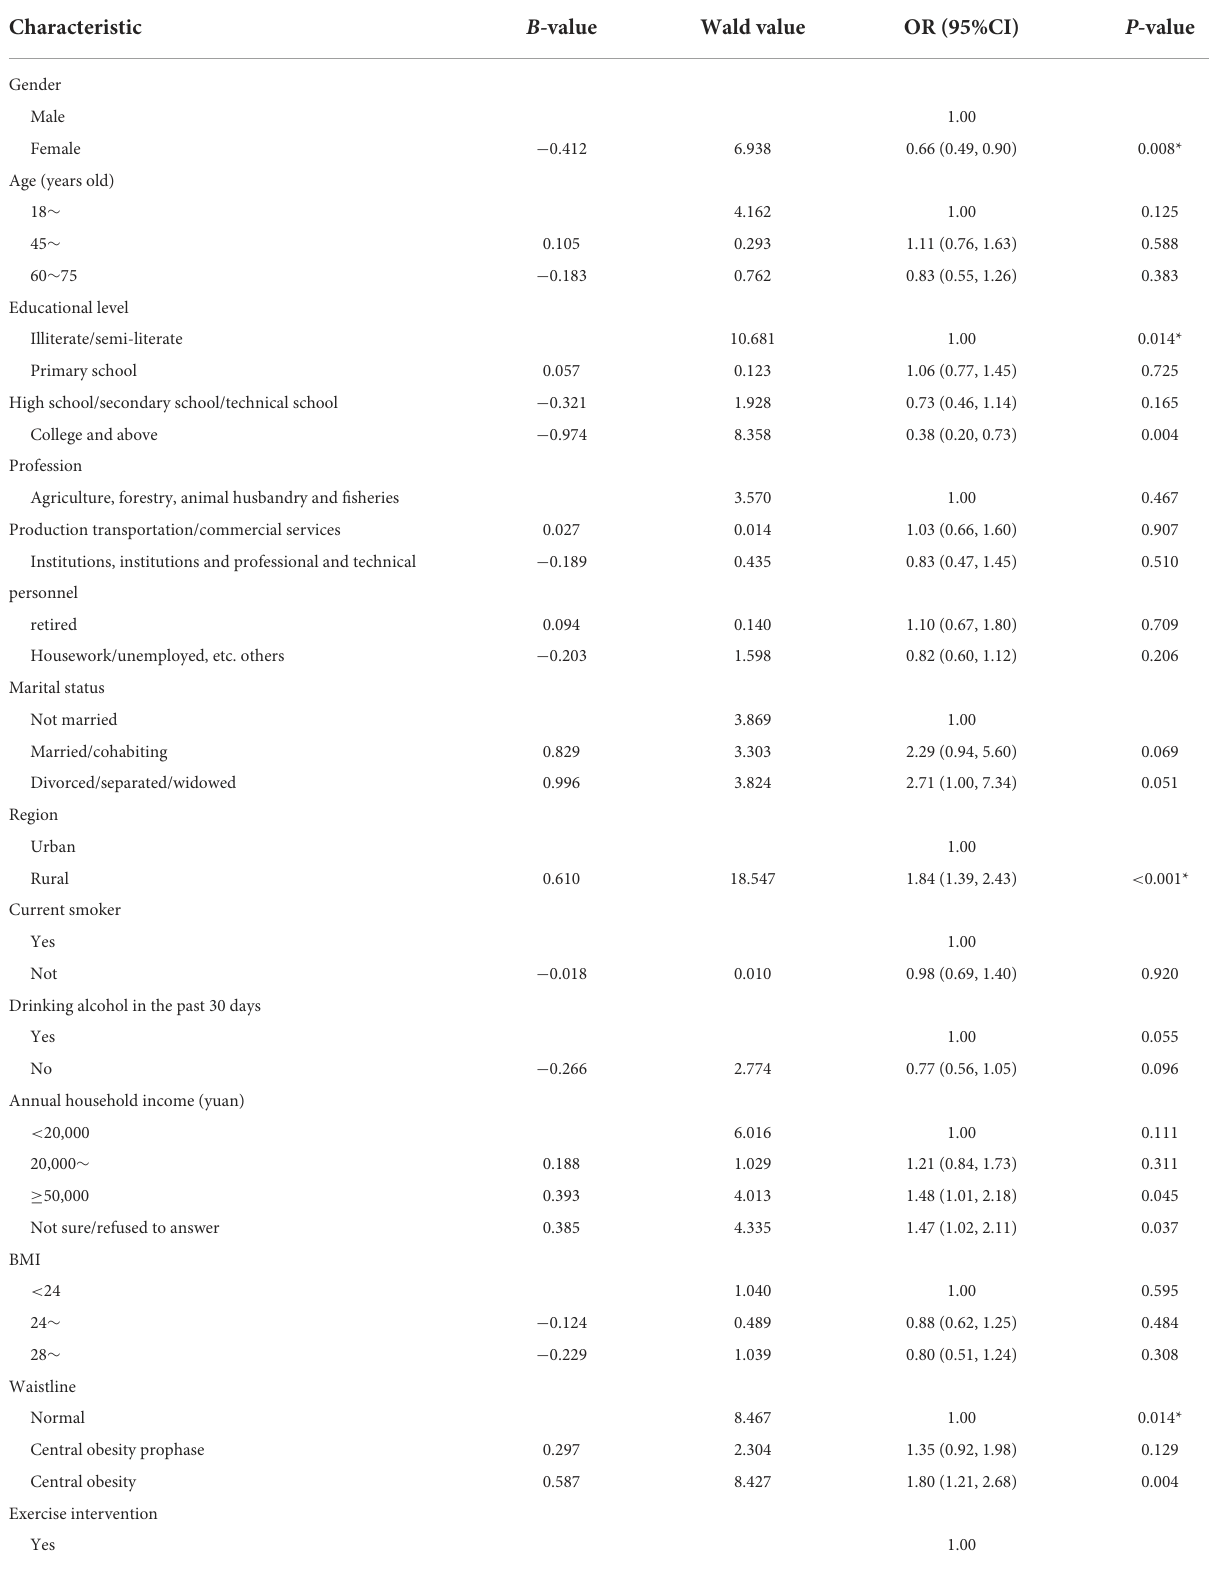
TABLE 3 Univariate analysis of glycemic control in patients with